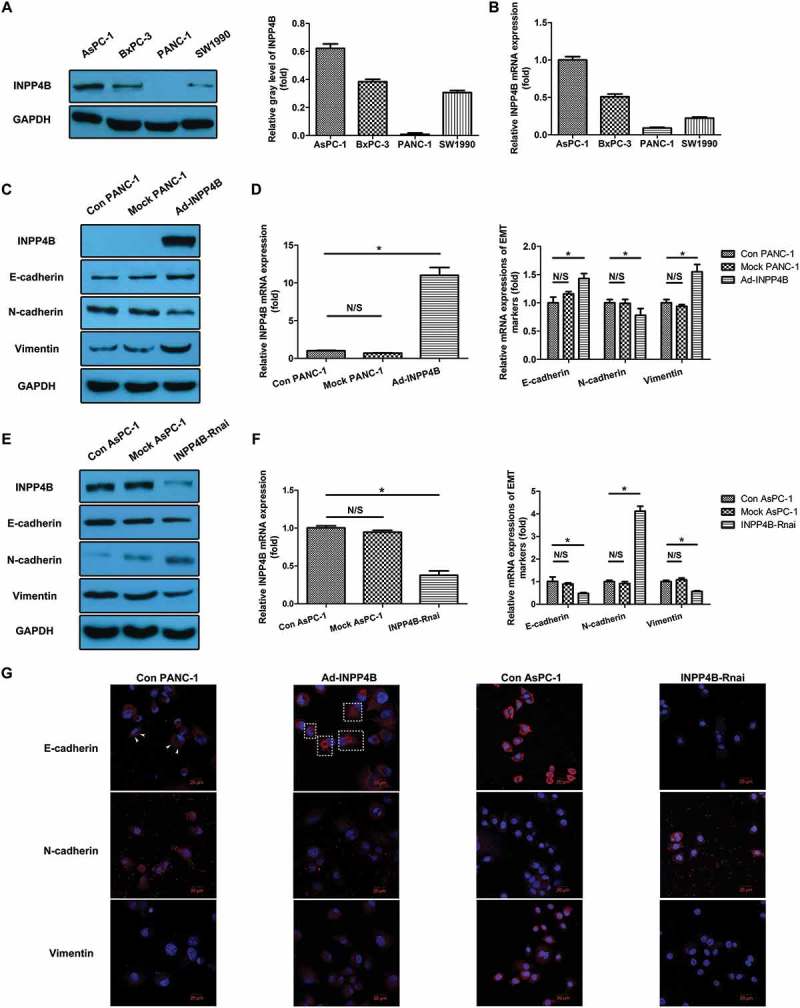
INPP4B expression in four PDAC cell lines and its impact on EMT marker in PANC-1 and aspc-1. Relative INPP4B expression level in four pancreatic cancer cell lines was quantified by western blot (a) and RT-qPCR (b) and listed as follows : AsPC-1> BxPC-3> SW1990> PANC-1 (All P < 0.05). The PANC-1 with relatively minimal INPP4B level was chosen for overexpression assay, and AsPC-1 with the highest INPP4B level among was selected for knockdown use. INPP4B overexpression induced upregulation of Ecad and Vim with downregulated Ncad in PANC-1 compared to that of the control in protein (c) and transcript levels (d). Knockdown of INPP4B in AsPC-1 led to reduction of Ecad and Vim with increased Ncad compared to control group (e, f). These results were further substantiated by immunofluorescence analysis for Ecad (g, top panel), Ncad (middle panel) and Vim (bottom panel) expression. Scale bar in images = 20 mm. The quantitative results of western blot and PCR were analyzed basing on gray-level ratio of target band and 2-△△Ct method. GAPDH was used as housekeeping gene for all data normalization. Results show mean ± SD (n = 3). N/S and * indicate P> 0.05 and P < 0.05. The boxes and arrowheads in merge images indicate regions of interest.